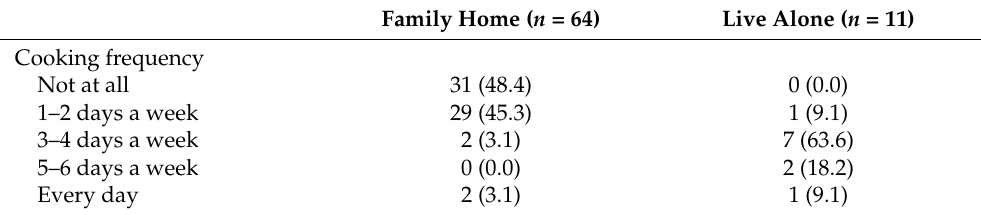
Table 1. Cooking frequency among female university students by living arrangements ( n = 75). Family Home ( n = 64) Live Alone ( n = 11)